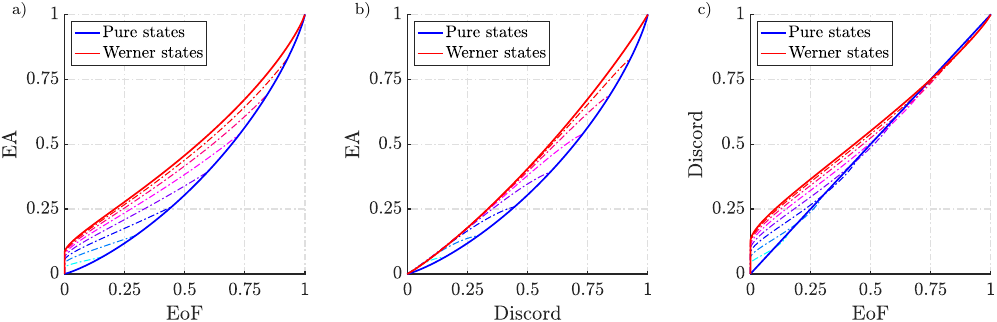
Figure 4. Comparison of EA with entanglement of formation (EoF) and discord for pure states with white noise. Each colour represents the group of states which is a mixture of noise and pure state parametrised by the Schmidt angle θ . Each line represents how the correlations evolve for the given pure state as we introduce noise. From (c) it is evident that discord asymptotes to entanglement for pure states whereas EA does not. EA does not asymptote to both the measures for the class of states under comparison. For a given EoF and discord, Werner states have the maximum EA. Werner states are states of the form ( 1 Bell singlet. Werner states are bipartite quantum states which are invariant under all unitary